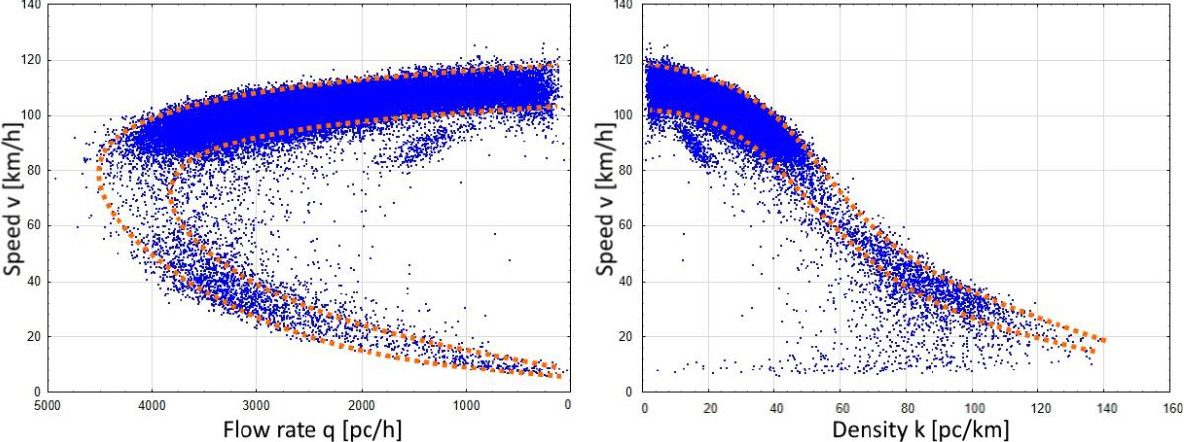
Figure 3. Empirical relations between speed, density, and flow.